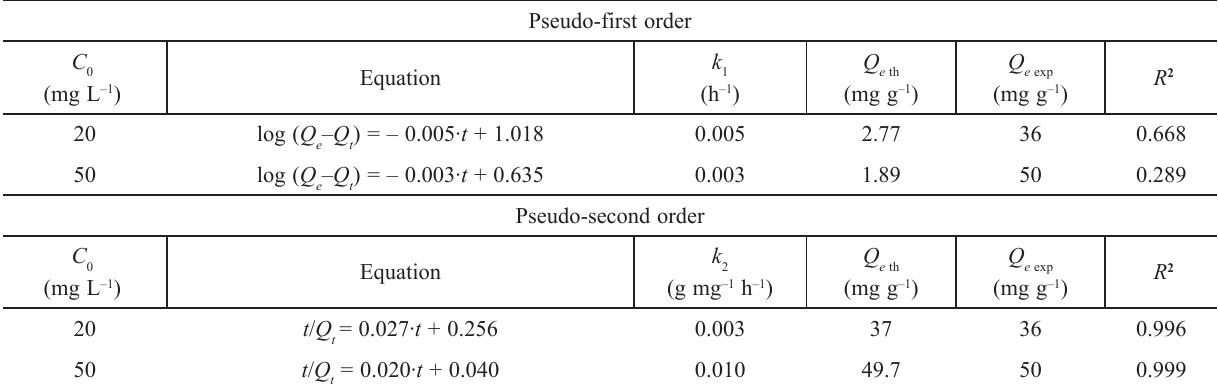
Table 1 – Parameters of the pseudo-first and pseudo-second order models and the maximum adsorption amounts of CA by CLDH Pseudo-first